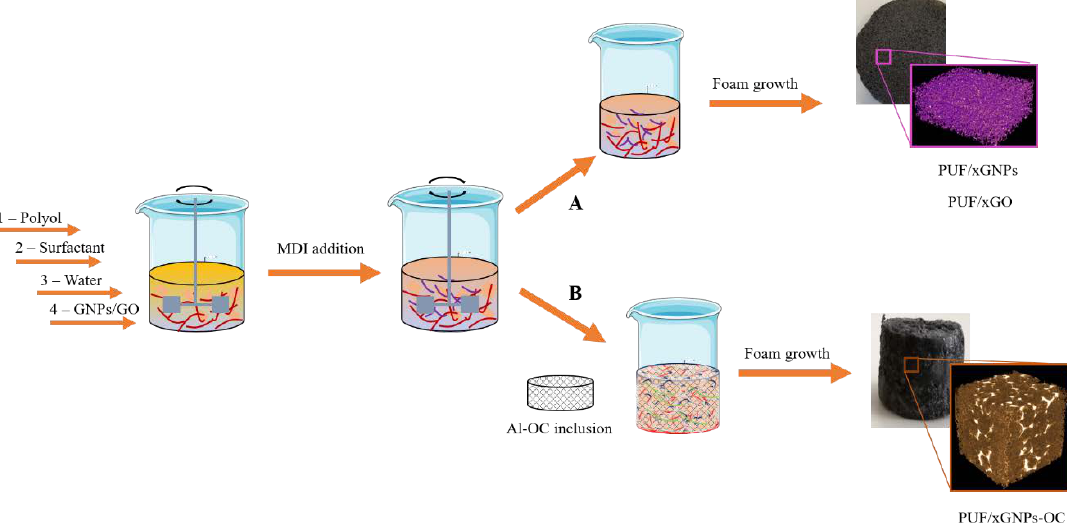
Figure 1. Scheme describing the preparation of: ( A ) polyurethane foam (PUF) nanocomposites; and ( B ) hybrid structures.